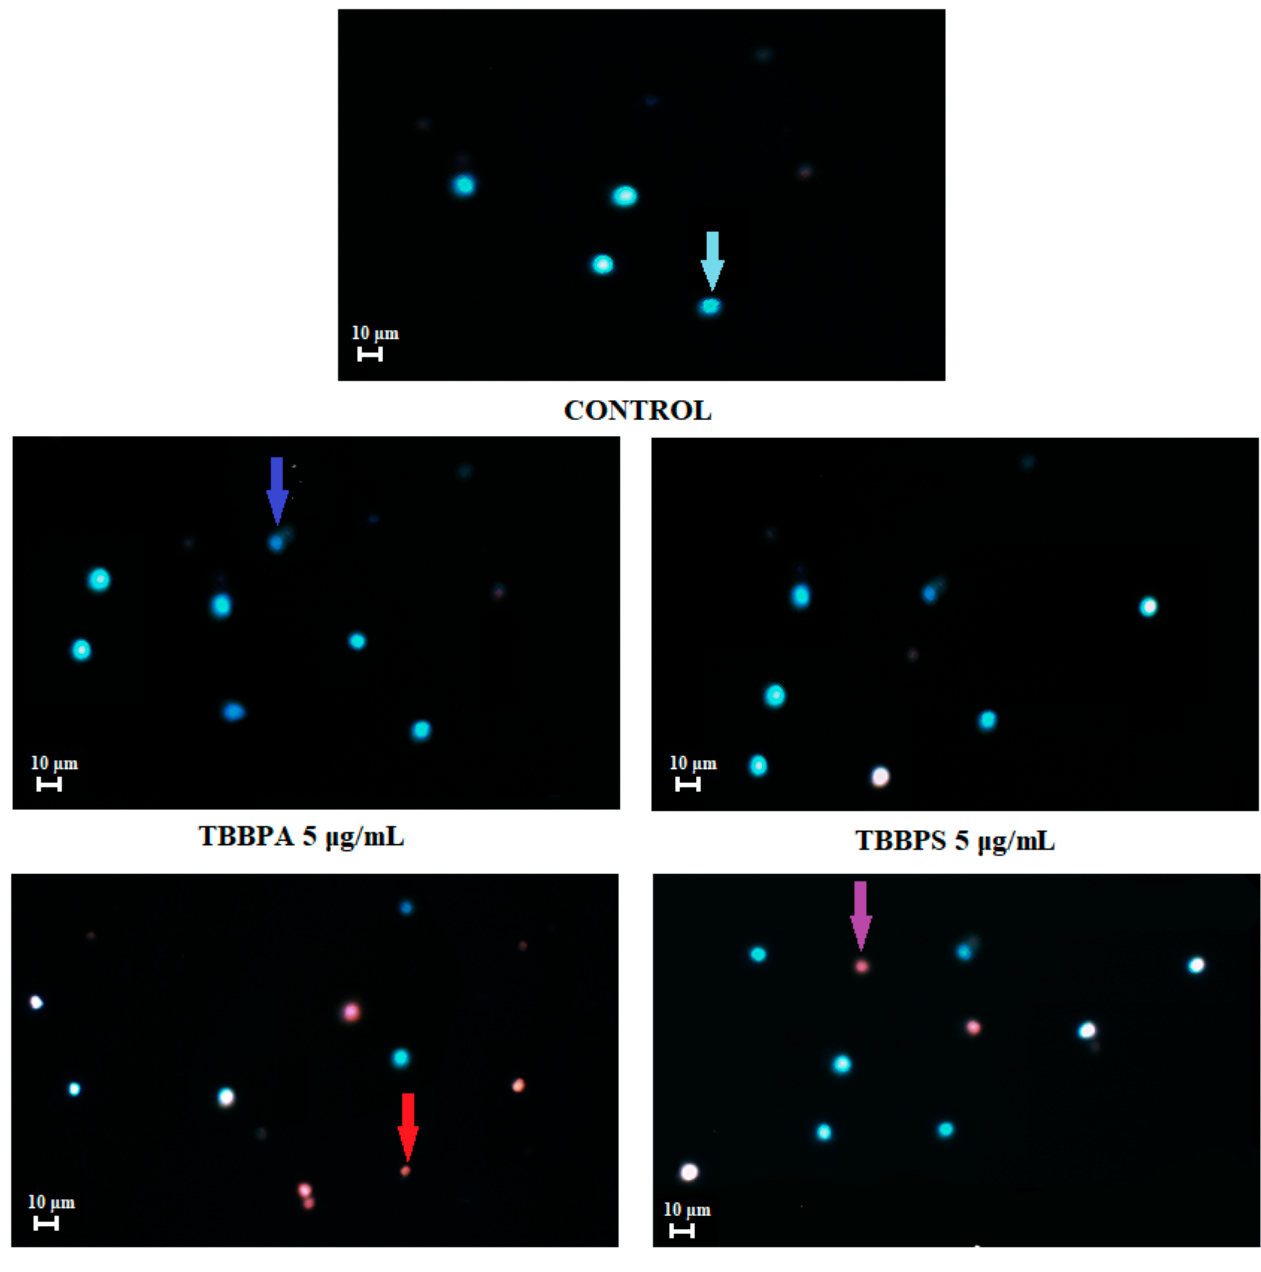
Figure 7. Apoptotic alterations in PBMCs treated with 0.2% DMSO (negative control), as well as with TBBPA and TBBPS at 5 µ g/mL and 50 µ g/mL. PBMCs were stained with Hoechst 33342 and PI. Viable cells (blue fluorescence), early apoptotic cells (intensive bright blue fluorescence),